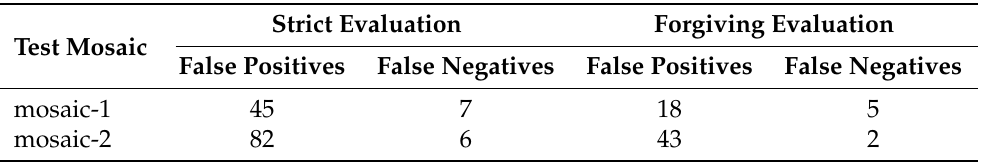
Table 7. Inspecting disc shape counts for two types of evaluation. Test mosaic ‘mosaic-1’ means that the model was trained on ‘mosaic-2’ and vice